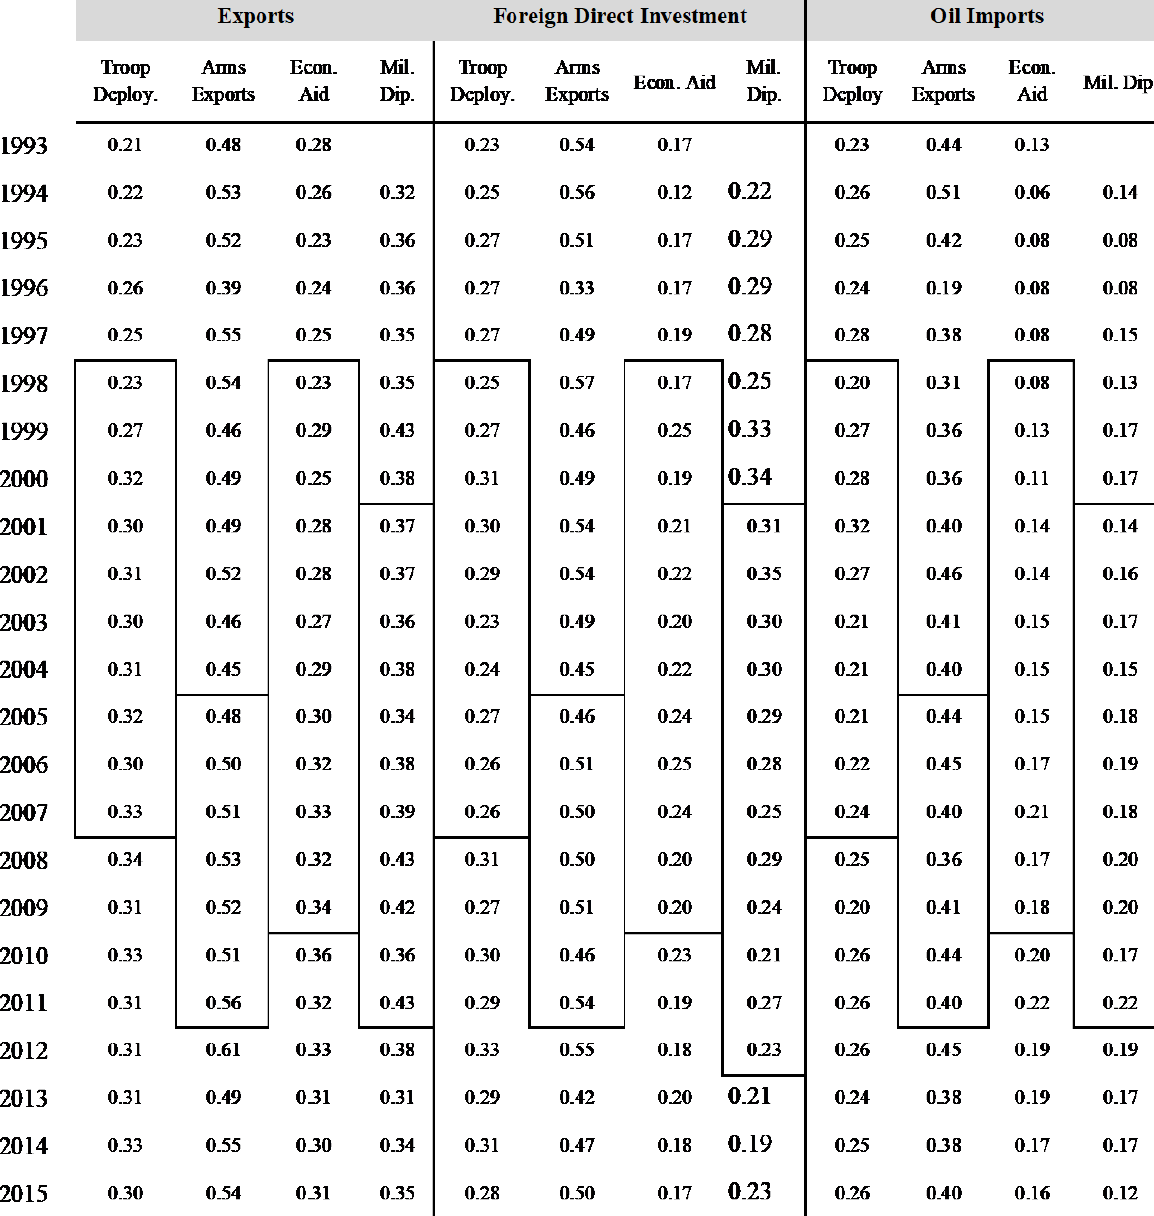
Table 2b: Jaccard Index, Economic and Political-Military networks US, 1993 - 2015. Key years of political-military network growth